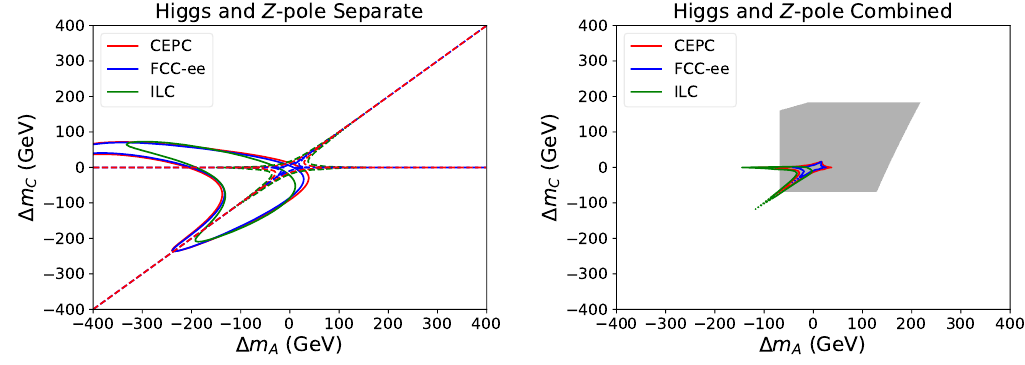
Figure 15 . Updated on July 17,